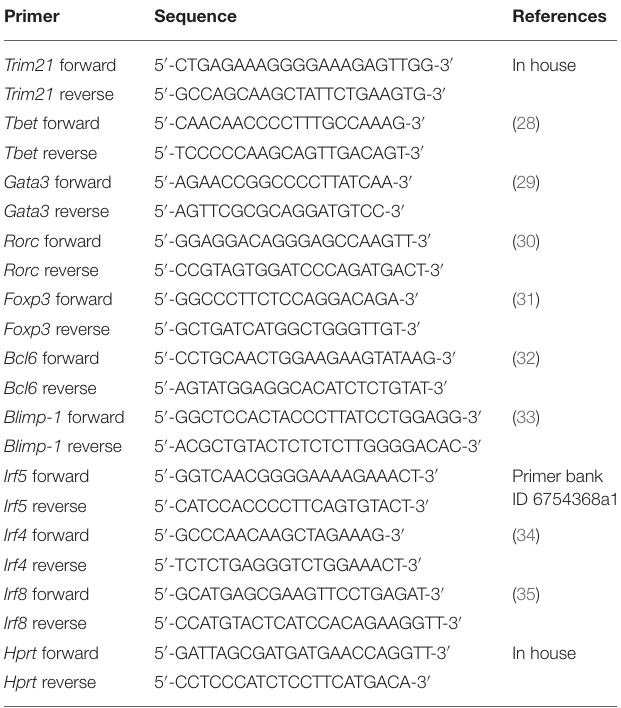
TABLE 1 | Mouse primer list used in